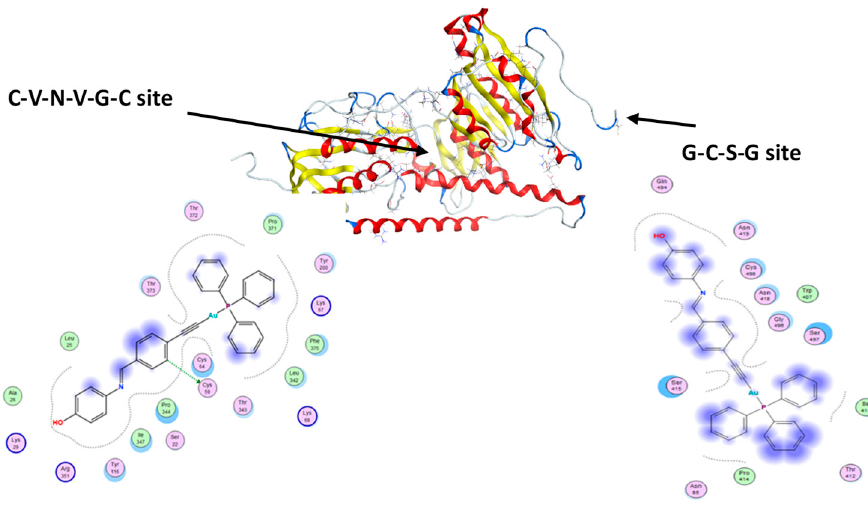
Figure 7. The interactions of complex 4 in the two active sites of the TrxR enzyme.